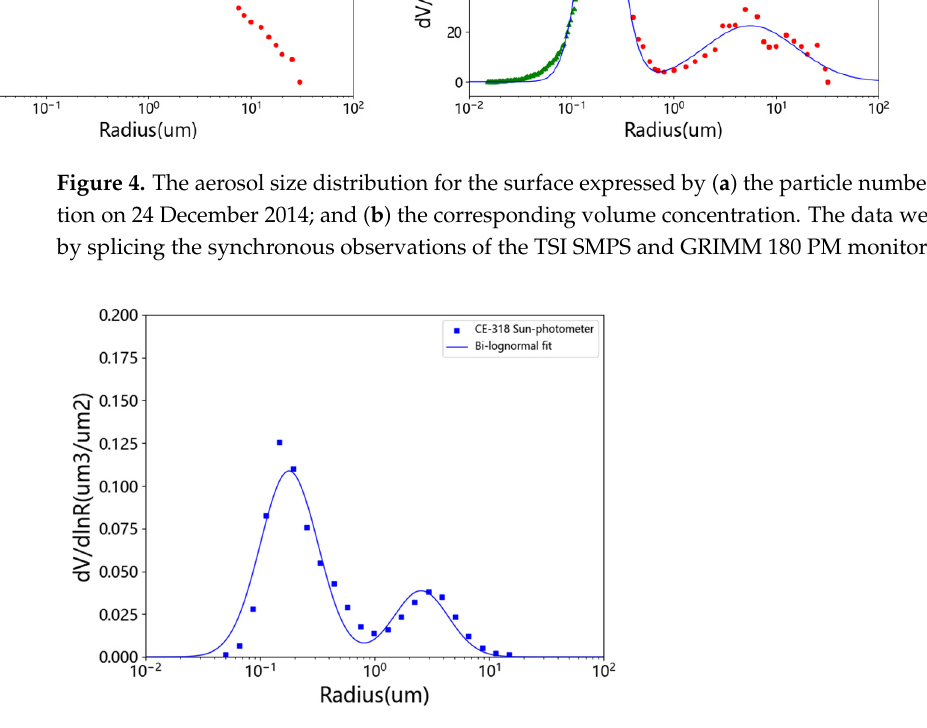
Figure 5. Columnar AVSD. The data were obtained by CE-318 sun photometer on 24 December